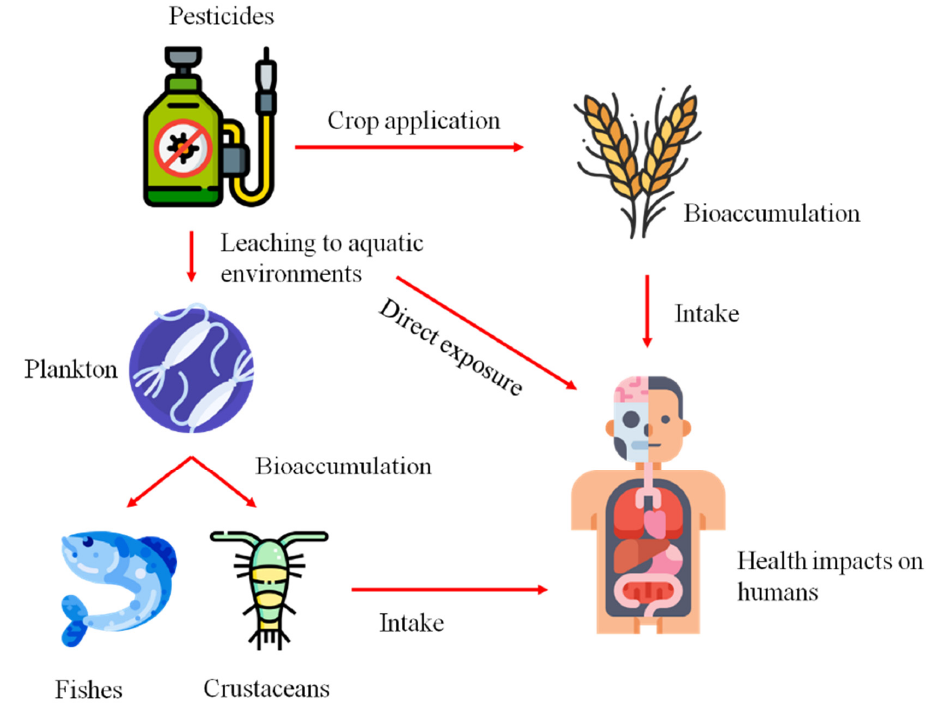
Figure 1. Risks of pesticides applications on water and plant species and human health.